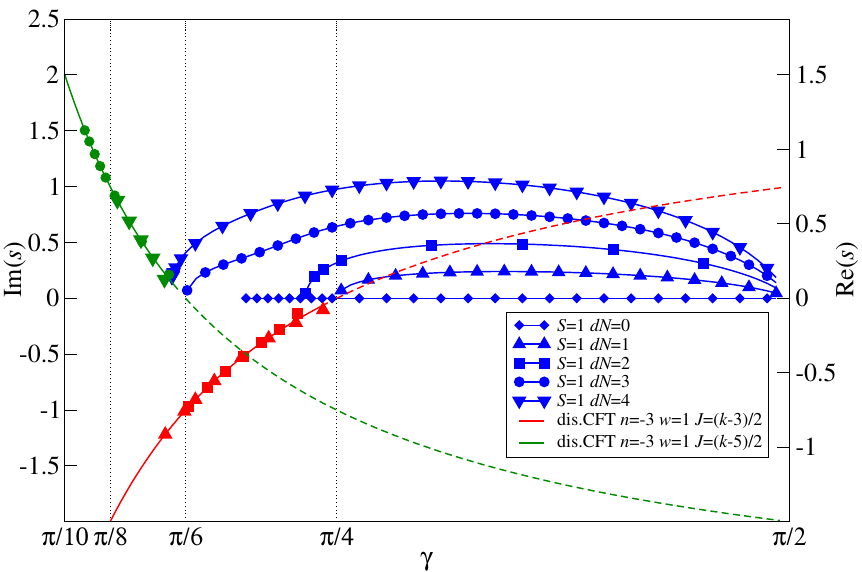
Figure 13 . Real (blue symbols) and imaginary (red and green symbols) part of the quasi- momentum s vs. anisotropy γ for the spin S = 1 states considered in figure 12. The solid red and green lines depict the quasi-momentum given by the CFT predictions via (6.16). Dashed lines are obtained by continuation of the CFT data into the region where the unitarity condition (6.11) is violated. Note that s ≡ 0 for the dN = 0